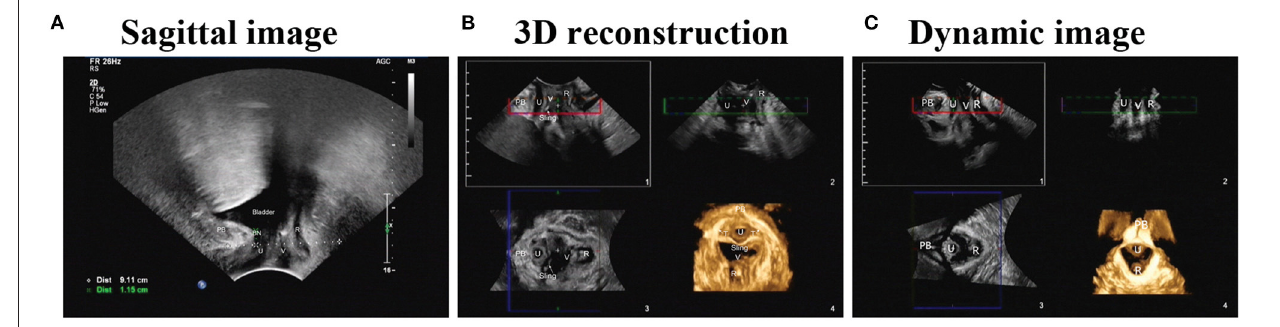
FIGURE 1 | Real-time dynamic ultrasound images of the mobility of bladder neck, urethra and sling at rest or valsalva maneuver. (A) Sagittal transperineal ultrasound image demonstrating the anatomic structure of the pelvic. PB, Pubic bone, BN, bladder neck; U, urethra; V, vagina; R, rectum. (B) Axial 3D reconstruction and dynamic ultrasound technologies allows the assessment of sling and pelvic structures in multi imaging planes in a patient with MUS implantation through a transobturator approach. (C) Dynamic ultrasound images detected during valsalva maneuver or at rest in a female patient.